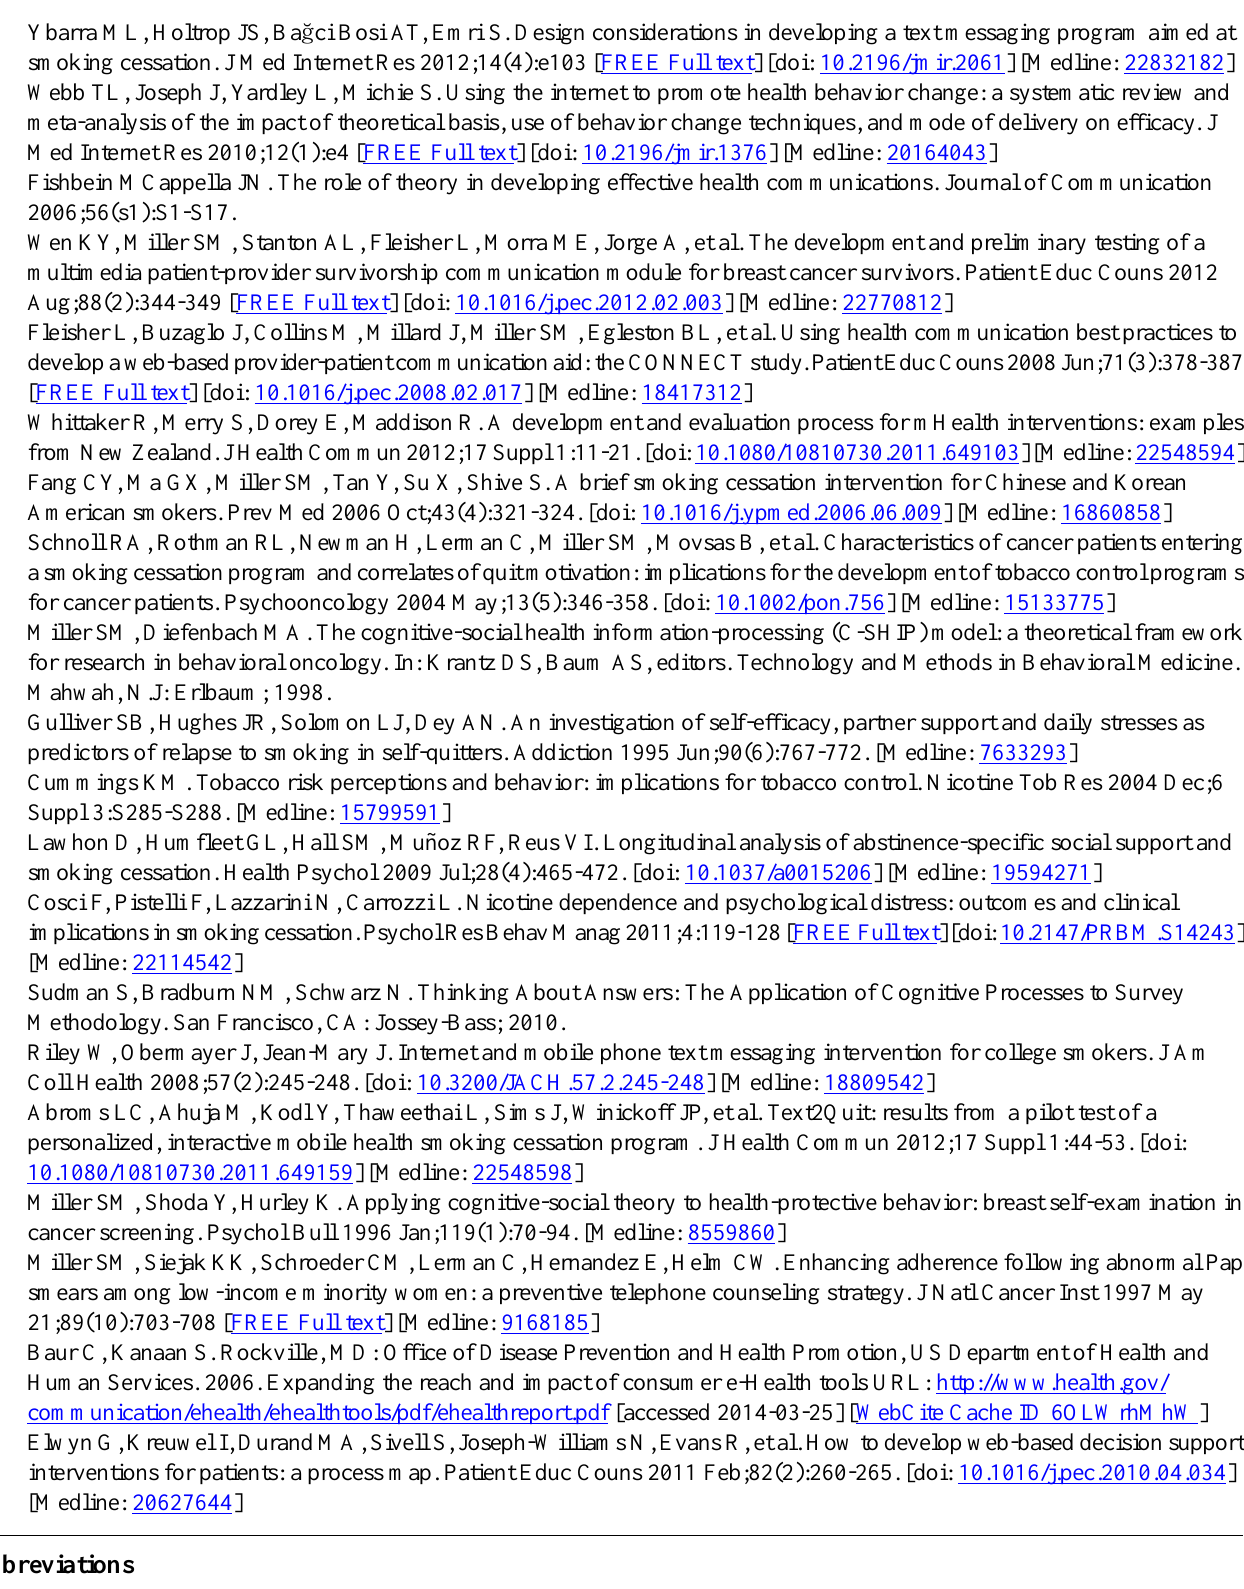
WIC: women, infants, and